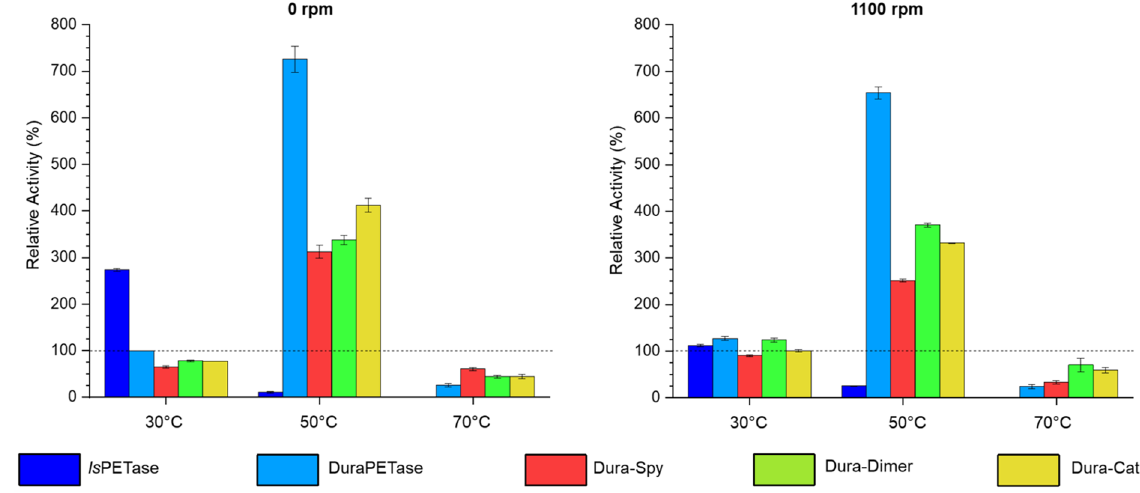
Figure 8. Relative PET degrading activity of the linear and cyclic DuraPETase variants as a percentage of the concentration of soluble degradation products released by DuraPETase after incubation with 7.5 mg/mL PET for 24 h at 30 °C, 0 rpm. Error bars represent the standard deviation from the